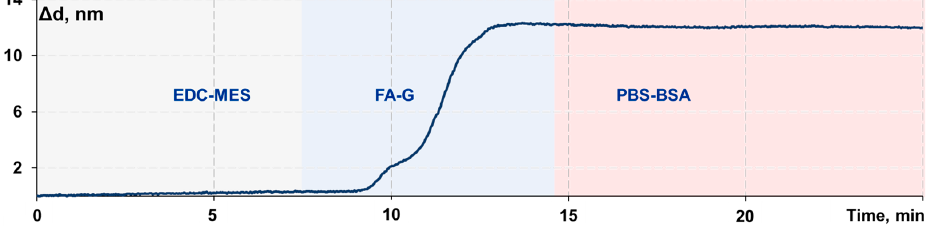
Figure 3. Complete cycle of assembly of the FA–gelatin conjugate layer on the sensor chip inside the SCI-based chemosensing system: EDS-MES—carboxyl group activator, FA–G—conjugate of folic acid with gelatin, PBS-BSA—blocking buffer.